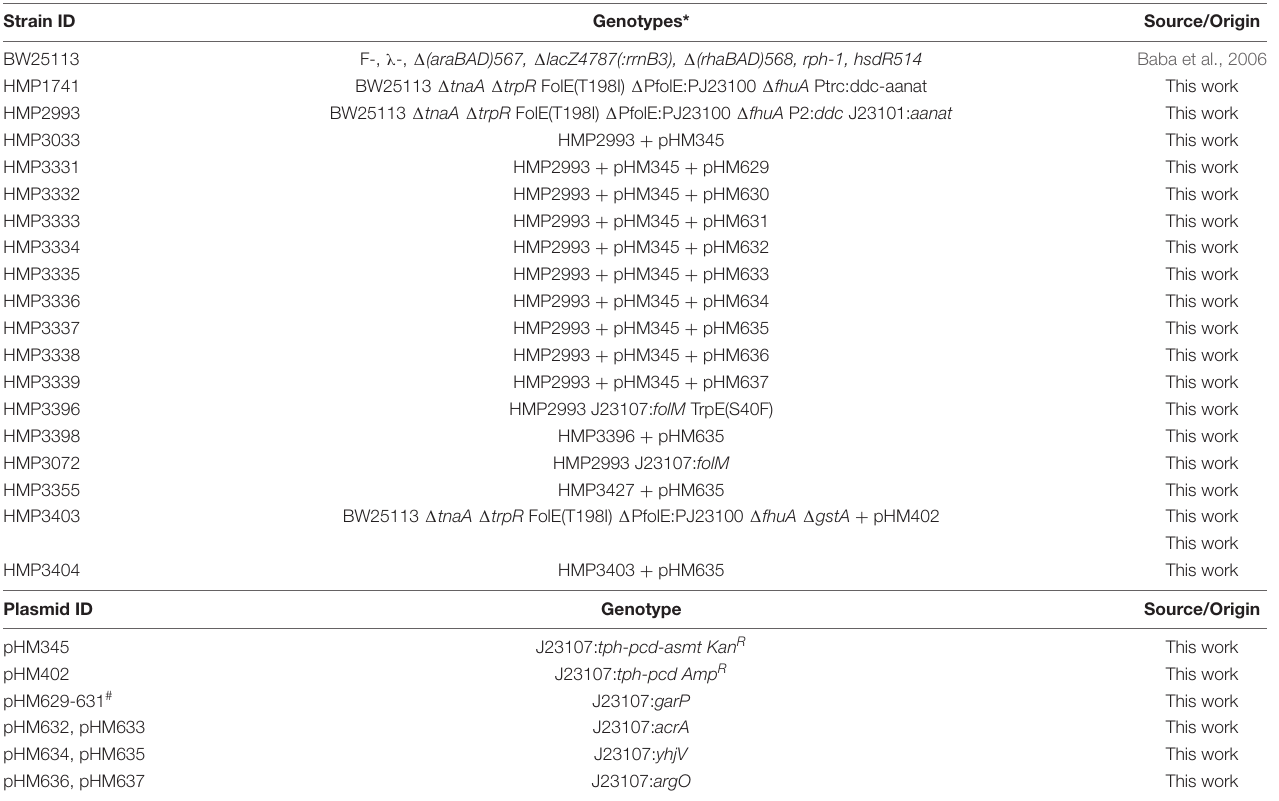
TABLE 2 | Strains and plasmids used in this study. Strain